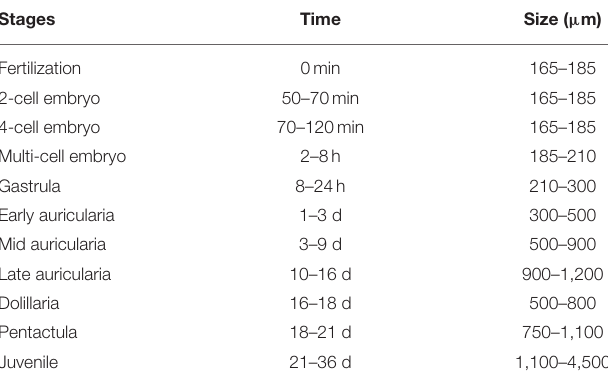
TABLE 3 | Summary of development in Holothuria scabra embryo, larvae and juvenile stages.